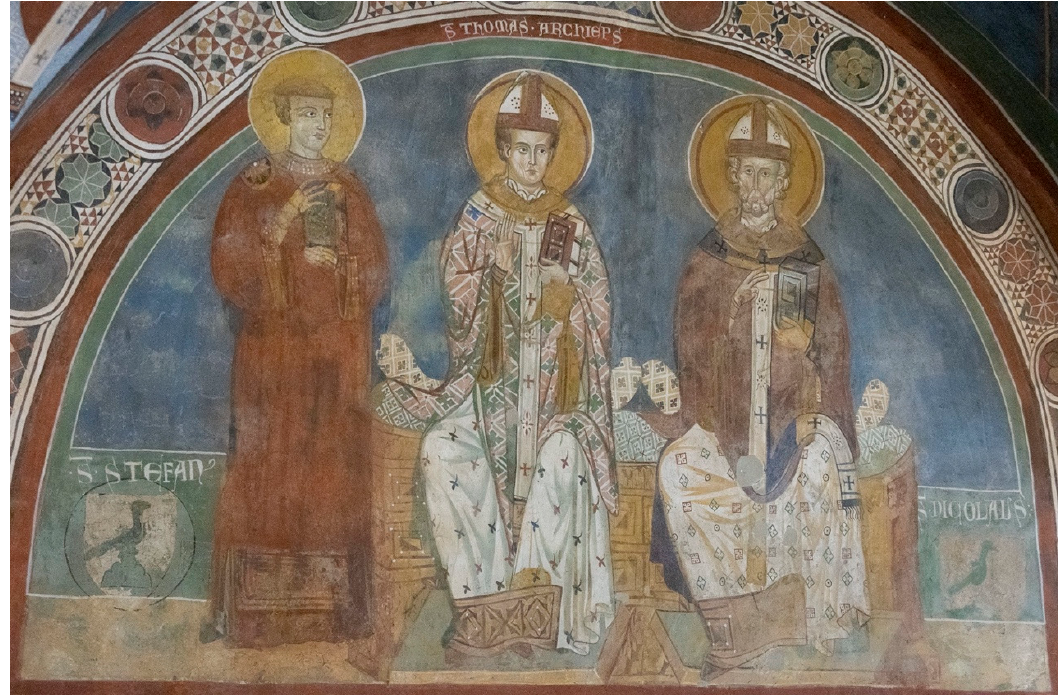
Figure 1. Sacro Speco, Subiaco (Italy), Lower Church. Fresco. Lunette with St. Stephan, St. Thomas Becket, St. Nicholas. Photo: Davide Giannetti.